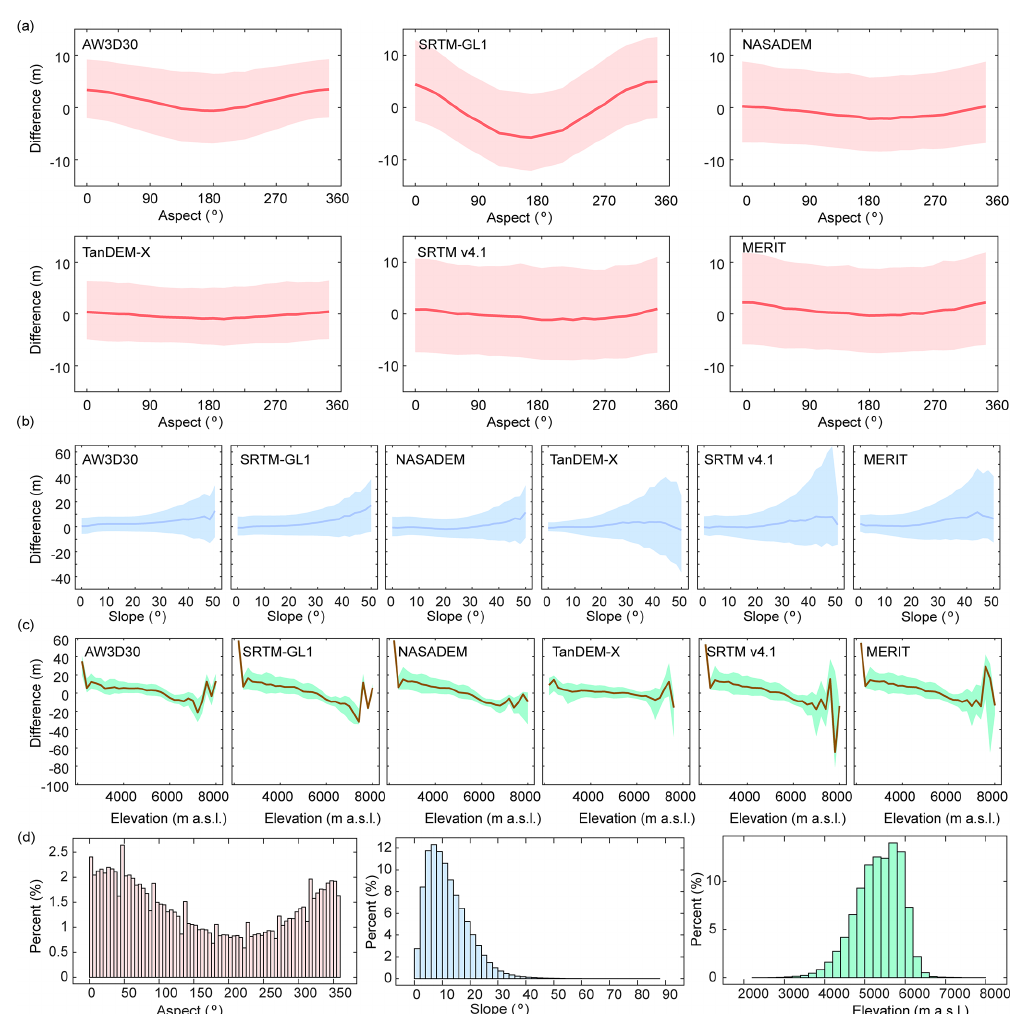
Figure 6. Differences between six DEMs and ICESat-2 with terrain factors: (a) 5 ◦ aspect bin; (b) 2 ◦ slope bin; (c) 200m elevation bin; and (d) percentage (%) of data in each aspect, slope, and elevation